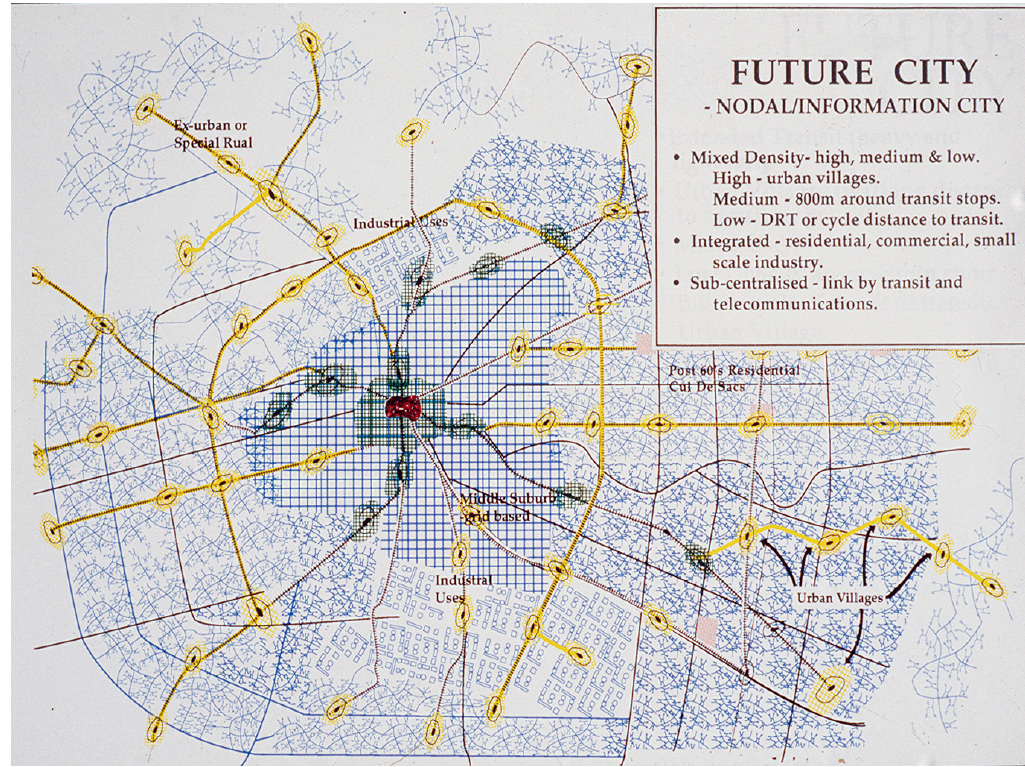
Figure 5. Relocalised city of the future based around nodes and linked across the city by quality transit routes. Source: Newman and Kenworthy [80].